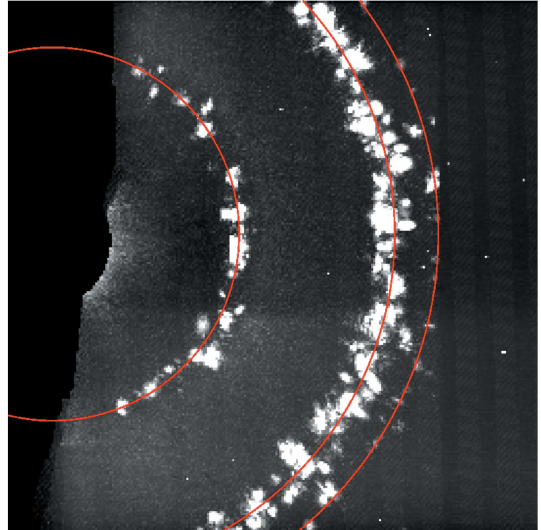
Figure 8 Virtual powder pattern from one run during the experiment. Photosystem I crystals have a hexagonal unit cell with a = b = 281 and c = 165.2 A˚ , space group P 6 3 . The innermost ring is comprised of 100-type reflections at a resolution of (cid:3) 41 m m (cid:2) 1 , the intermediate ring contains nearly overlapping 110- and 101-type reflections at resolutions ’ 72 m m (cid:2) 1 and the outermost ring consists of 200-type reflections at (cid:3) 82 m m (cid:2) 1